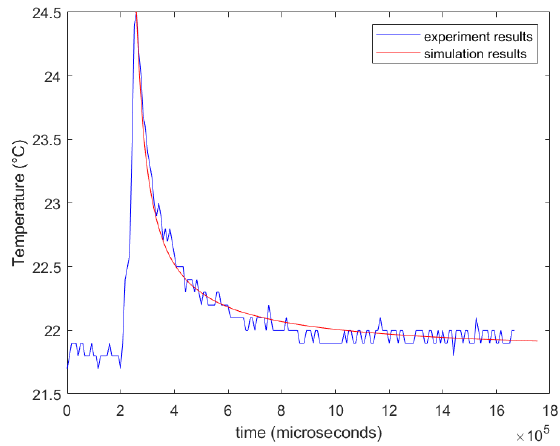
Figure 11. The Δ T images of the CFRP specimen after the impact with a steel ball (experiments vs. simulations).